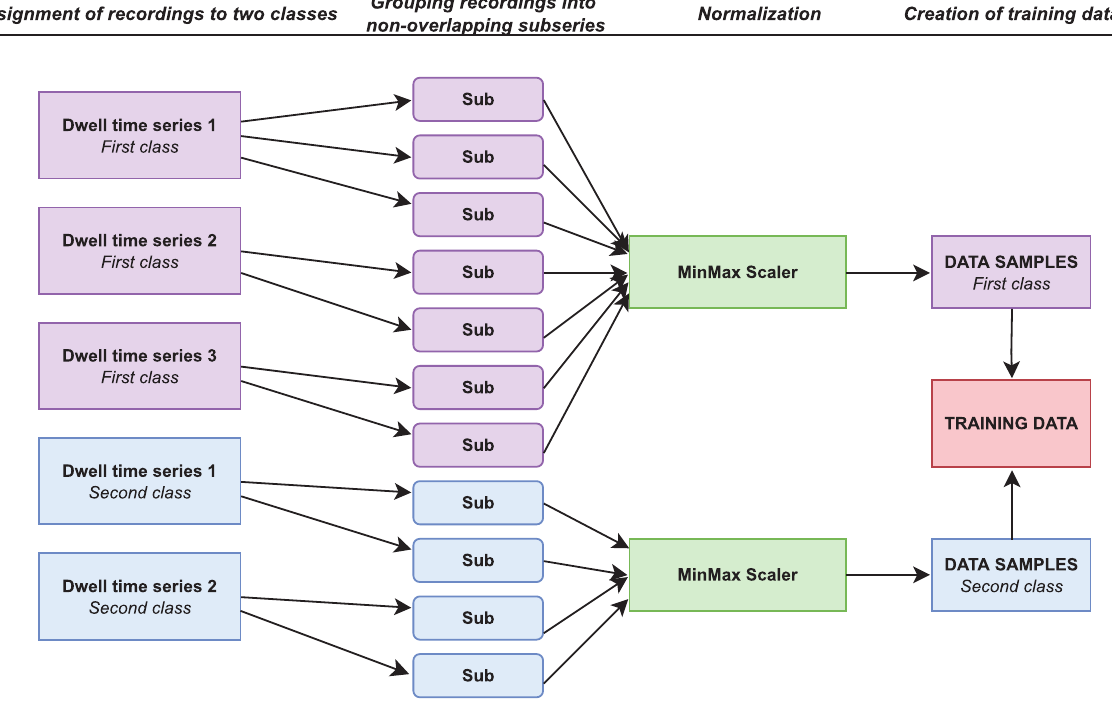
Fig 7. The preprocessing stage of the raw dwell-time series. Before feeding the data into a machine learning algorithm the dwell-time series are assigned to the appropriate classes. They are then divided to the non–overlapping subseries of 50 elements, grouped together and globally normalized to the range [0, 1]. At the end, data samples coming from all classes are combined to create the ultimate